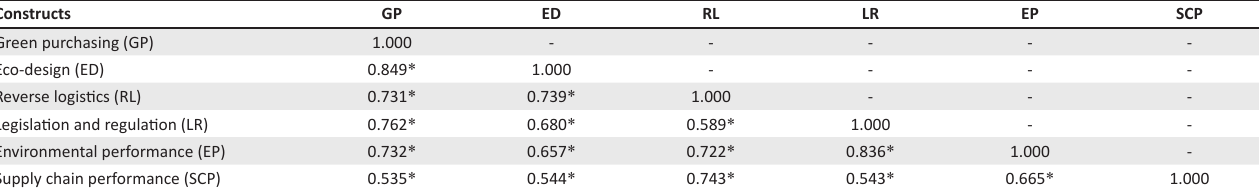
TABLE 5: Correlations between constructs. Constructs